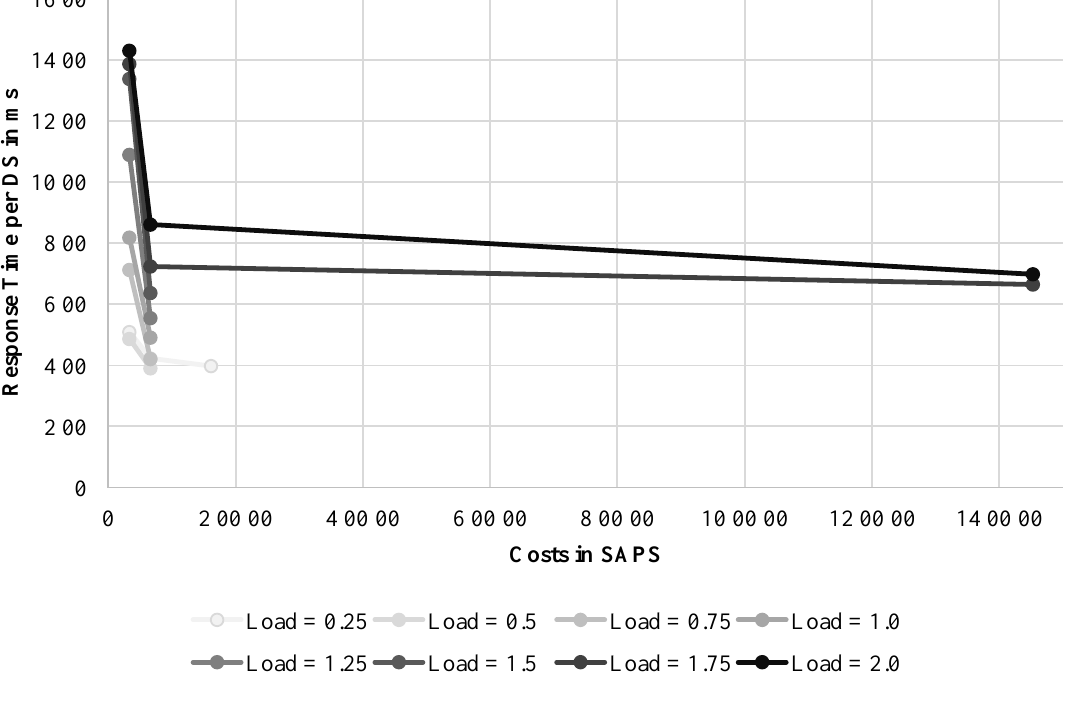
Figure 4. Set of Pareto-optimal